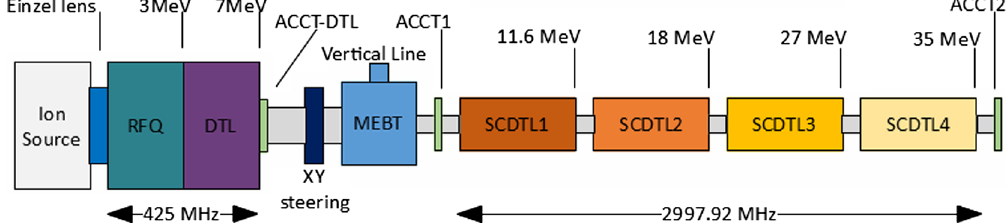
FIG. 3. Schematic layout of the TOP-IMPLART linac up to 35